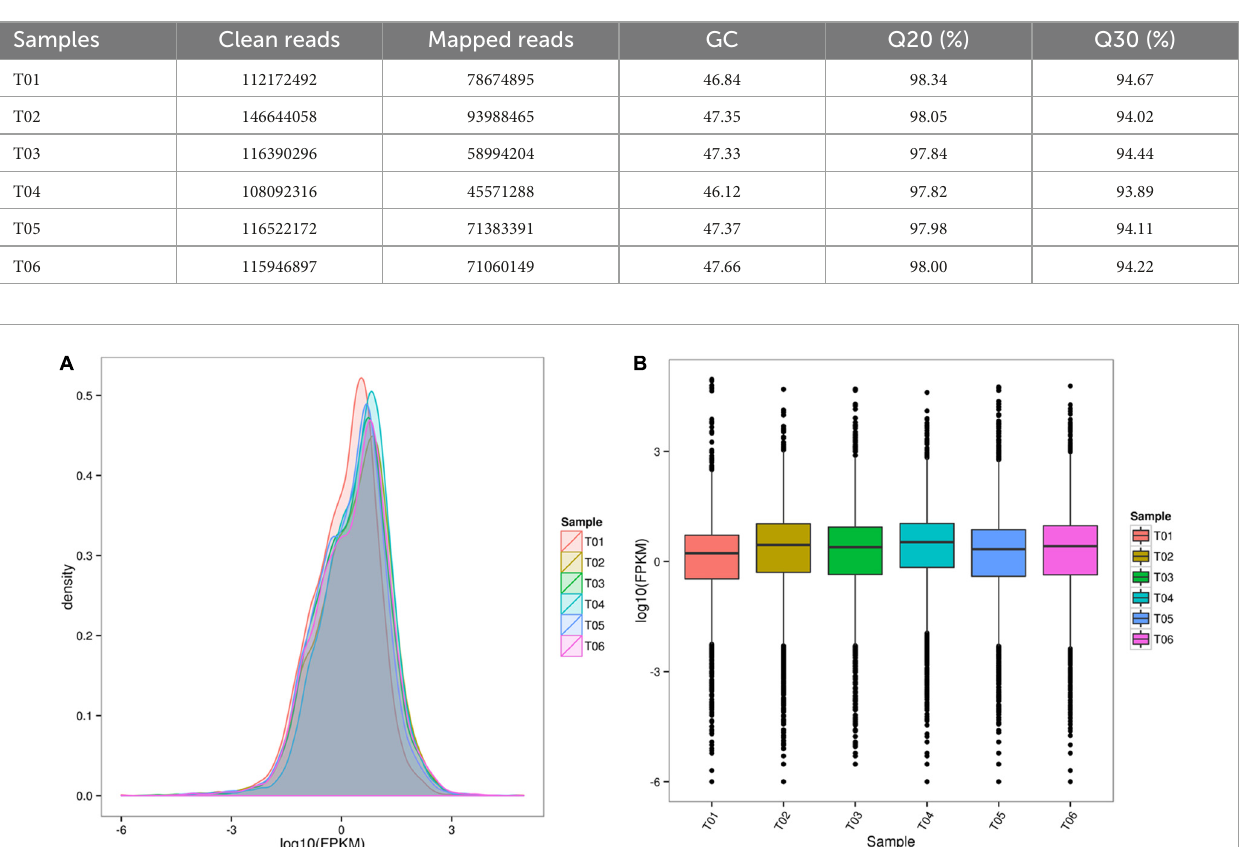
Cluster of Orthologous Groups of proteins (COG) (Tatusov et al., 2000), and Kyoto Encyclopedia of Genes and Genomes (KEGG) (Kanehisa et al., 2004) databases to obtain annotation information of the new